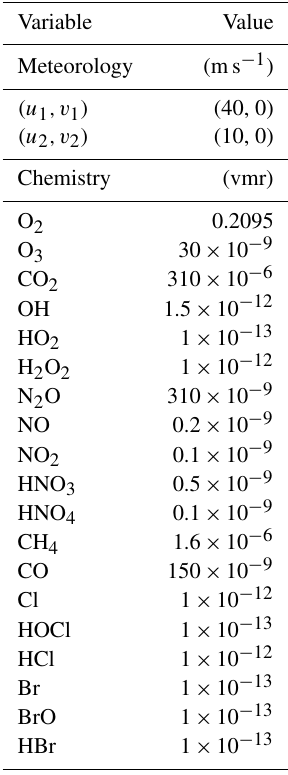
Table 2. Initial conditions used to initialize the truth simulation. The initial fields are constant over the QG-Chem domain. Same values are also assigned to the meridional boundaries of QG-Chem dur- ing all simulations. Values are equal to zero for chemical species that are not listed below. Chemical concentrations are expressed in volume mixing ratio units (vmr).